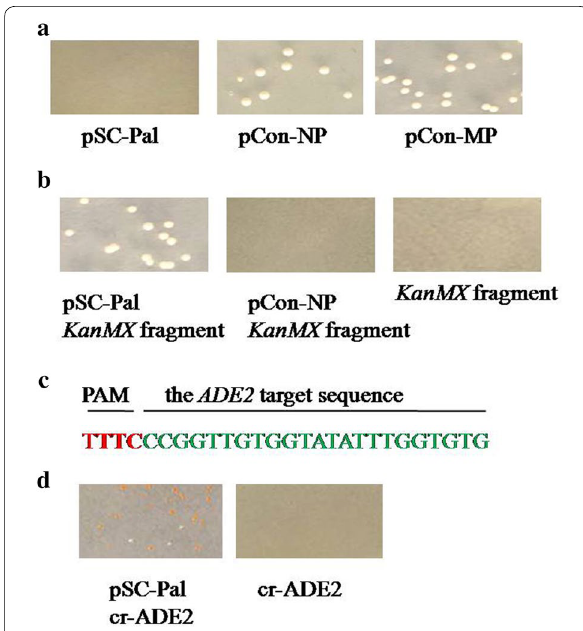
Fig. 2 Functionality of scCRISPR/Cpf1. a Pictures of transformants obtained by transforming pSC‑Pal (left), pCon‑NP (middle) or pCon‑MP (right). b Pictures of transformants obtained by transforming the KanMX fragment with pSC‑Pal (left), the KanMX fragment with pCon‑NP (middle) or the KanMX fragment only (right). c The cr‑ADE2 target in the ADE2 . d Pictures of transformants obtained by transforming cr‑ADE with pSC‑Pal (left) or cr‑ADE only